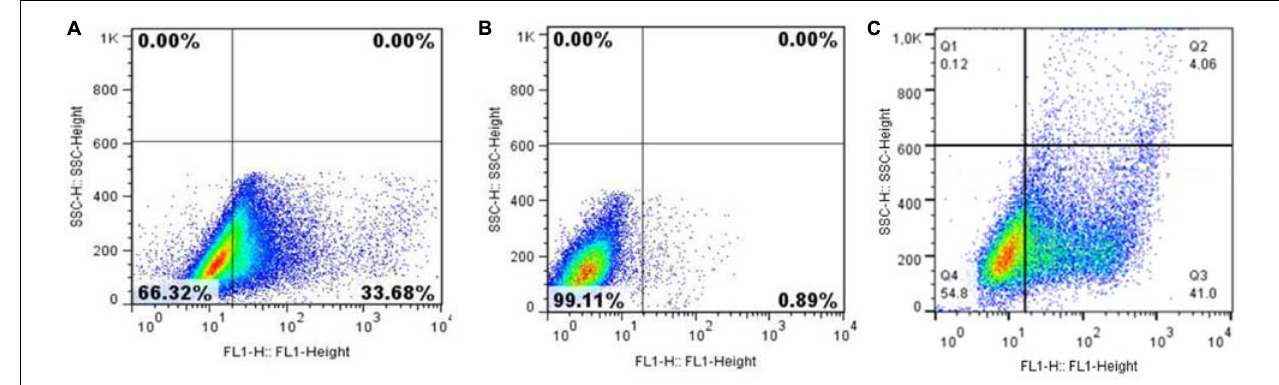
FIGURE 3 | Expression of the Ag85A protein by CHO cells transfected with pValac: Ag85A vector. Single fluorescence-activated cell sorter (FACS). Dot Plots representing (A) transfected CHO cells labeled with primary (Mab DT-17/4) and secondary [goat anti-mouse IgG (H+L)] antibodies, (B) non-transfected CHO cells labeled with primary (Mab DT-17/4) and secondary [goat anti-mouse IgG (H+L)] antibodies (negative control), (C) pValac: gfp transfected cells (positive control). Images obtained using FlowJo